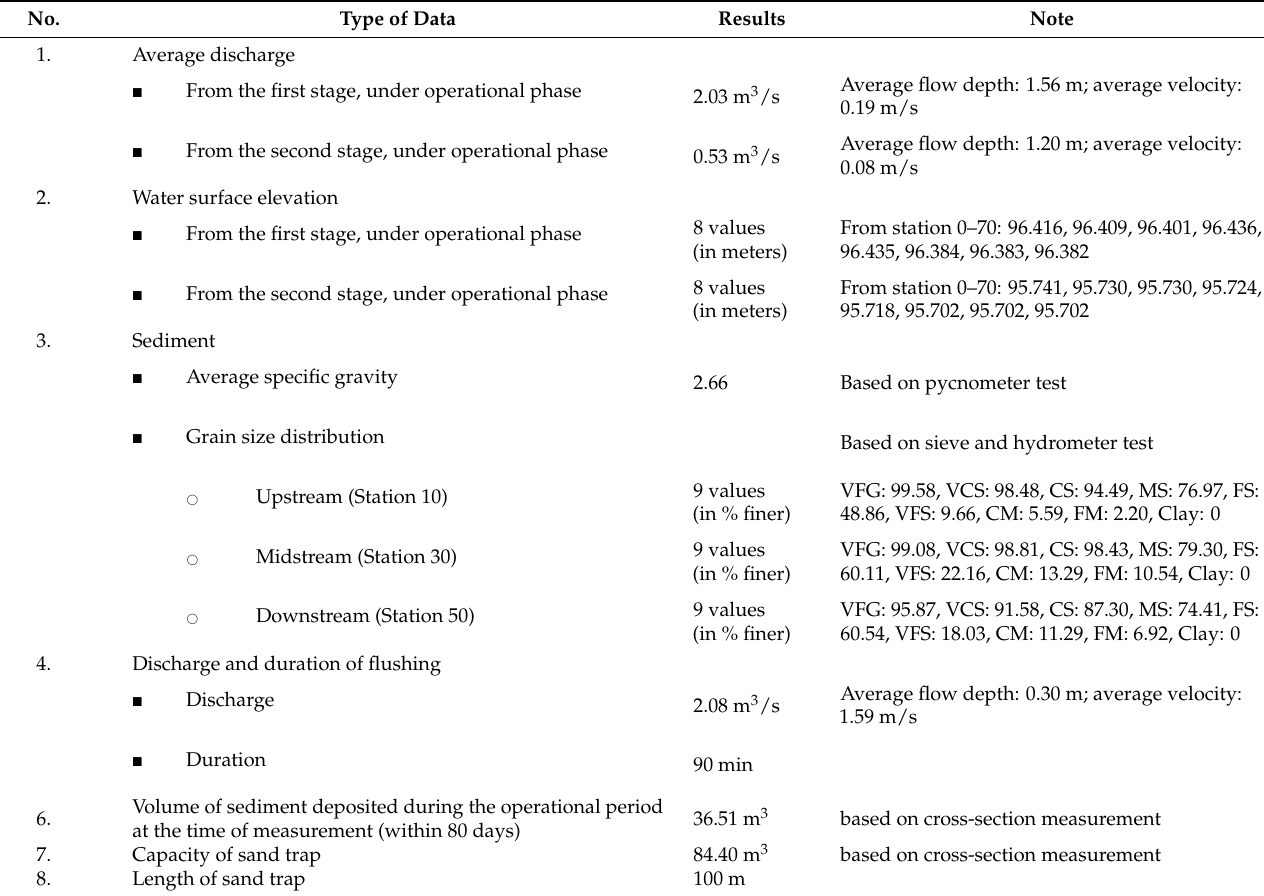
Table 1. Summary of the collected primary